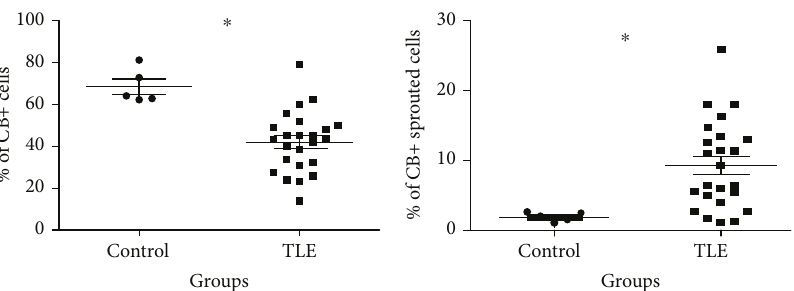
Figure 3: Semiquantitative analysis of dentate gyrus CB immunoreactivity observed in TLE patients and postmortem controls. Postmortem controls showed a signi fi cant higher number of CB+ cells, with a signi fi cant reduction of CB+ sprouted cells comparing with TLE patients ( ∗ Student ’ s t -test, p < 0 05 ).